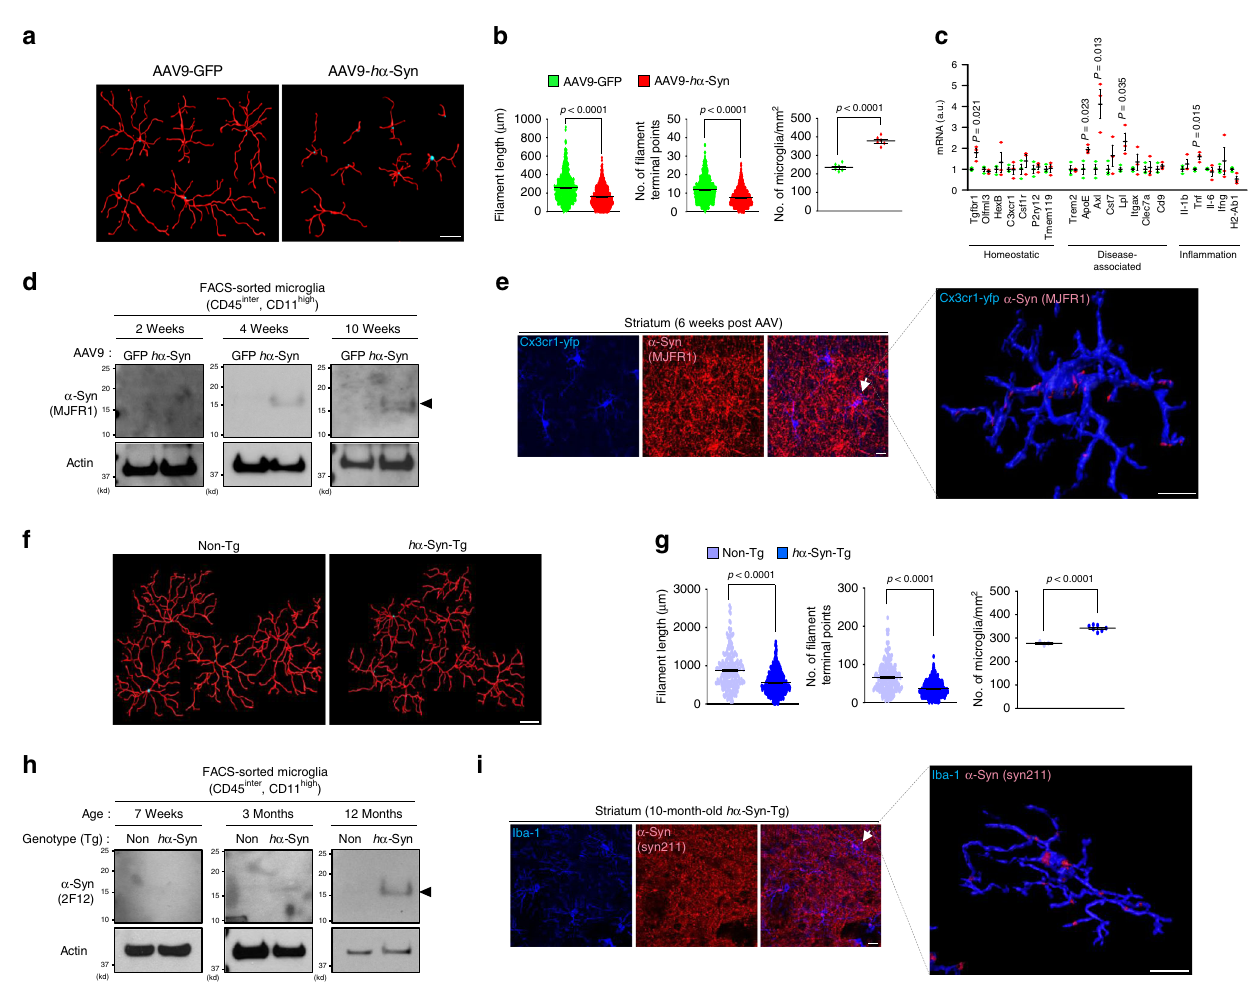
Fig. 1 Neuron-released α -synuclein is engulfed by microglia in vivo. a , b , f , g Brain sections from AAV-GFP ( n = 768 cells, six animals) and AAV- h α -Syn- injected mice ( n = 986 cells, six animals) at 6 weeks post AAV injection ( a , b ) or from 10-month-old Non-Tg ( n = 246 cells, three animals) and h α -Syn-Tg ( n = 478cells, seven animals) mice ( f , g ) were stained for a marker of microglia, Iba-1, to visualize microglia morphology in the striatum. Reconstruction of microglia processes was generated by Filament-Tracer tool in Imaris software ( a , e ) and fi lament lengths ( p < 0.0001) and the number of terminal points ( p < 0.0001) were quanti fi ed (left panels in b and g ). The number of microglia at the striatum was counted using ImageJ software (NIH, Bethesda, MD) (right panel in b ( p = 6.59E-07) and g ( p = 4.88E-05)). p -values were calculated by two-tailed Mann – Whitney U test (the left two panels) and unpaired two-tailed Student ’ s t test (the right panel). Scale bar, 10 µ m. c CD45 intermediate and CD11b high microglia were isolated from brains injected with AAV- h α - Syn ( n = 3) and assayed for RT-qPCR using primers as indicated, compared with AAV-GFP ( n = 3) at 4-weeks after AAV. p -values were calculated by unpaired two-tailed Student ’ s t test. d , h Pooled CD45 intermediate and CD11b high microglia were prepared either from AAV-GFP ( n = 3) and AAV- h α -Syn- injected mice ( n = 3) ( d ) or Non-Tg ( n = 4) and h α -Syn-Tg ( n = 4) mice ( h ) brains at the indicated time points and lysed for W.B using α -synuclein antibodies (MJFR1 clone in d , 2F12 clone in h ) and actin. e , i Brain sections from Cx3cr1 CreER-IRES-Eyfp mice injected with AAV- h α -Syn were stained using anti-GFP/YFP antibody and human α -synuclein antibody at 6 weeks after AAV ( e ), and brain sections from 10-month-old Non-Tg and α -Syn-Tg mice were stained using Iba-1 antibody and human α -Synuclein antibody ( i ). 3D reconstruction of microglia and human α -synuclein was produced using Imaris software (Bitplane, right panel) as described in the “ Methods" section. Scale bar, 10 µ m. All values are reported as mean ± SEM. Data are representative of three independent